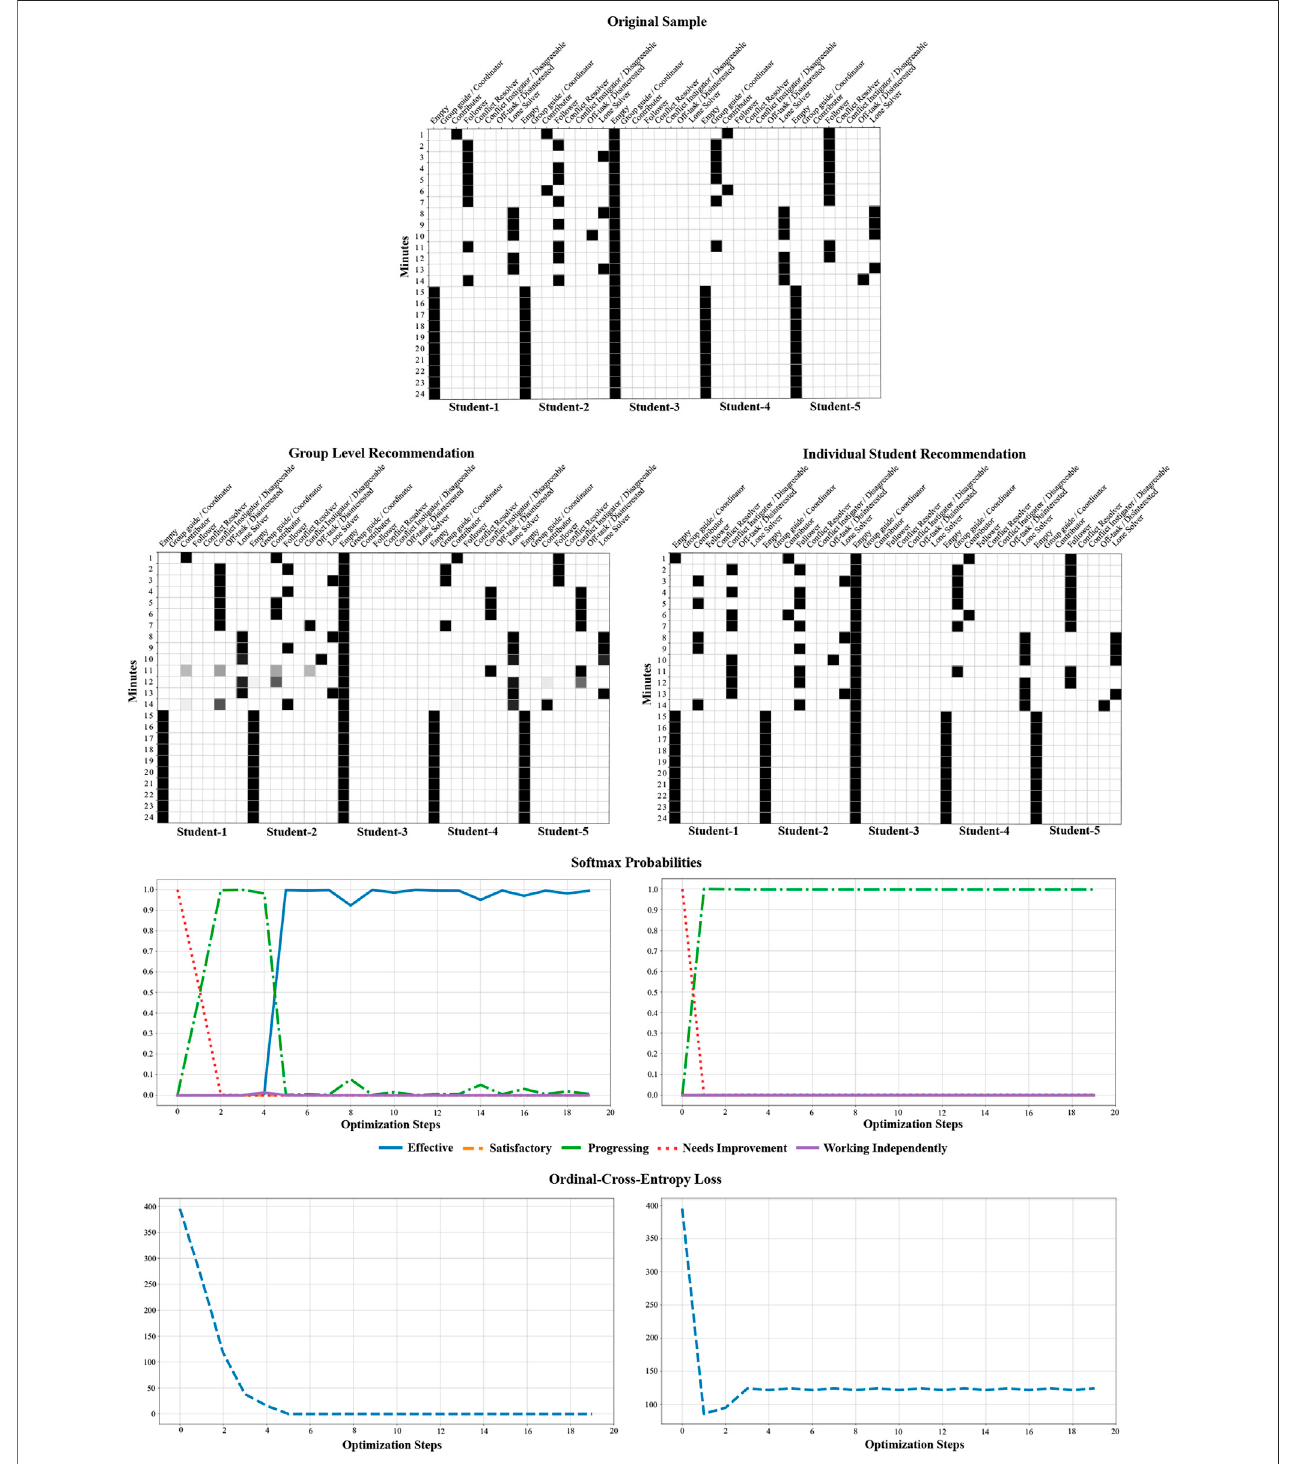
FIGURE 11 | Illustration of group level and individual student level recommendations for Level B2.